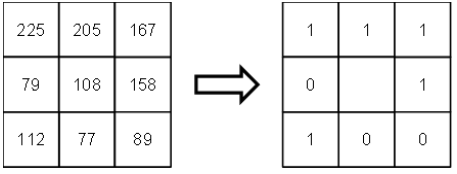
Figure 4. Sample LBP descriptor taking